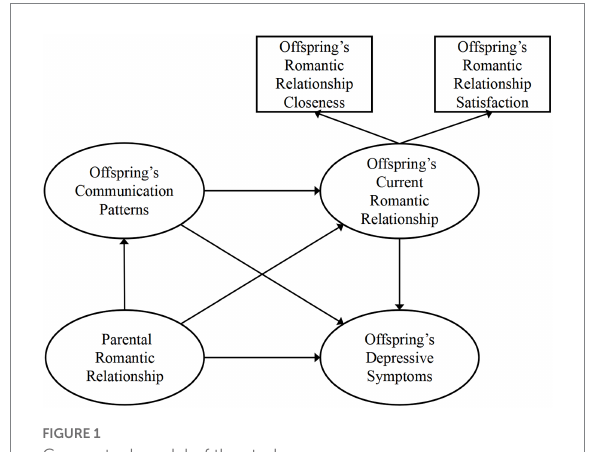
FIGURE 1 Conceptual model of the